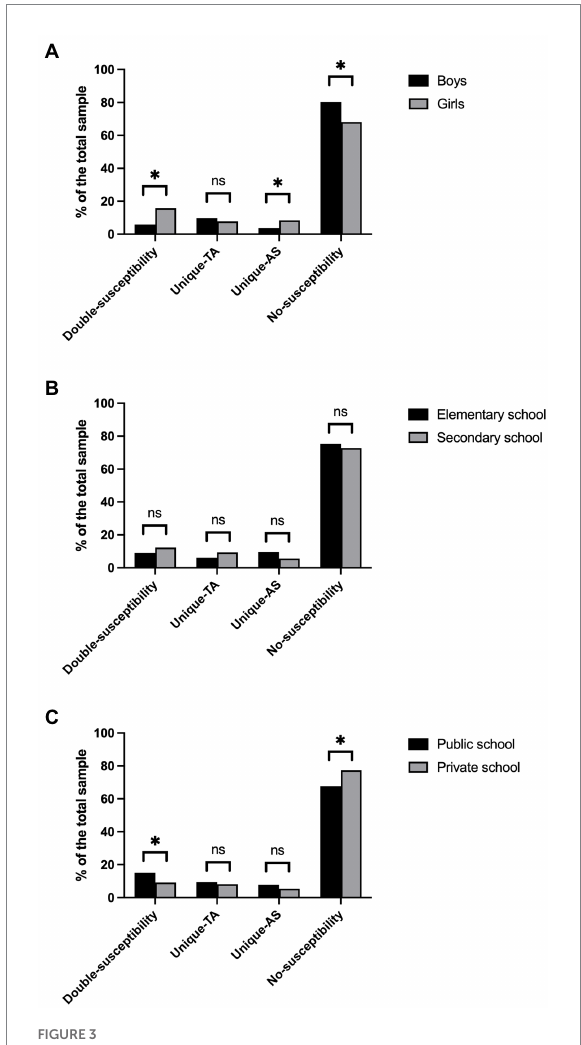
FIGURE 3 Latent profiles’ membership across genders (A) , school levels (B) , and school types (C) . * p <